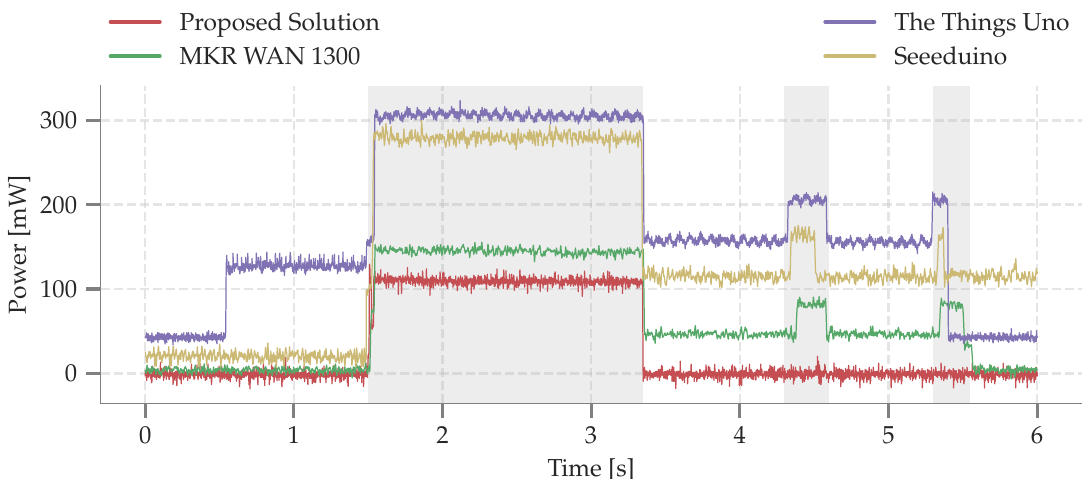
Figure 4. Power consumption of the considered platforms when transmitting a packet of 20 Bytes at SF12 with a transmit power of 14dBm. The platform wakes up, transmits a packet, and opens two receive windows.